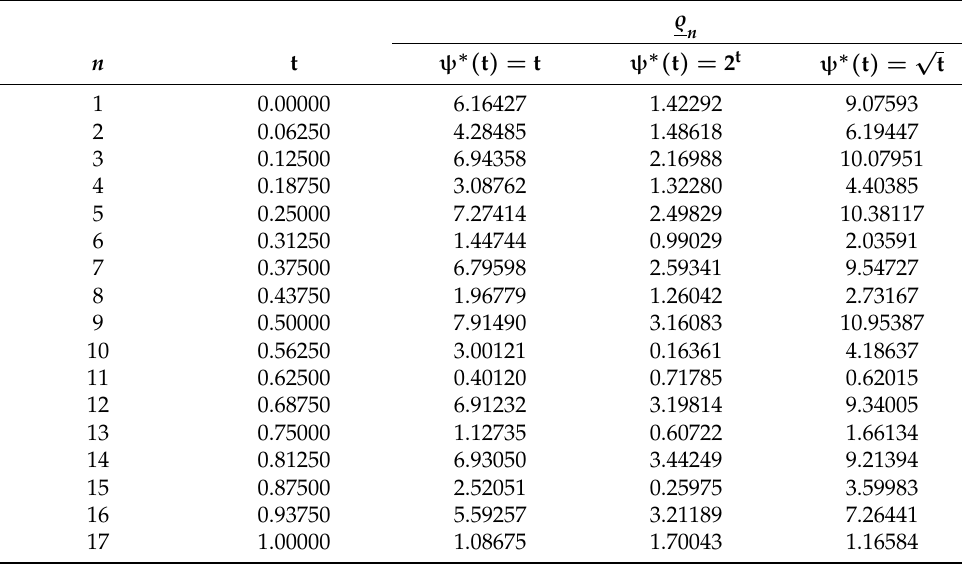
for ψ ∗ ( t ) = t,2 t , n